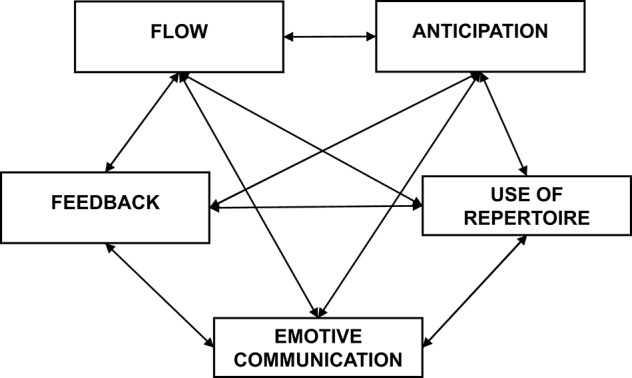
The dimensions of musical improvisation from Biasutti (2015).